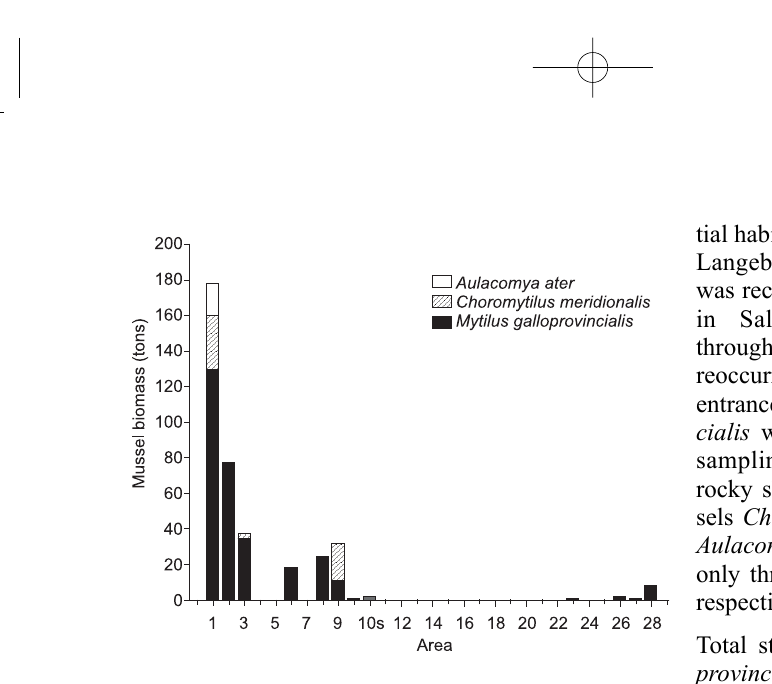
Fig. 2. Total biomass supported by Mytlius galloprovincialis in each sampling